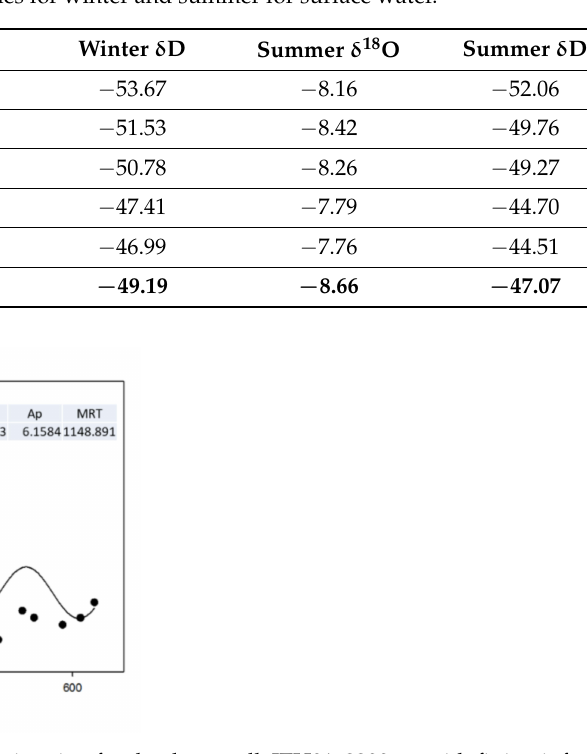
Figure 7. The mean residence time estimation for the deep well, ITH01, 2200 m, with fitting informa- tion. A is the seasonal amplitude of δ 18 O for groundwater, Ap is the seasonal amplitude of δ 18 O for precipitation, and b’ is a conversion factor.